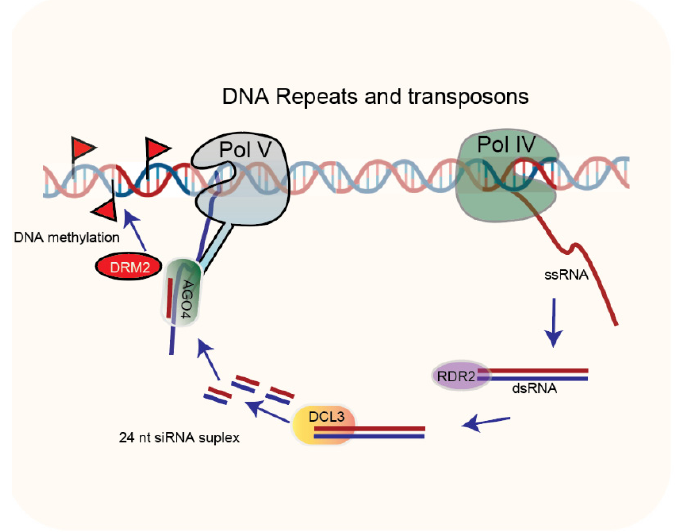
Figure 3. Pol IV initially transcribes DNA repeats and transposons. RNA-dependent RNA polymerase 2 (RDR2) then produces dsRNAs, DCL3 to process dsRNAs to 24-nucleotide siRNAs, which are stabilized by methylation on their 3 ′ -terminal 2 ′ -O-methyl group that is introduced by HEN1 and then loaded onto AGO. The AGO4 recruits DOMAINS REARRANGED METHYLTRANSFERASE 2 (DRM2) during Pol V mediated transcription, responsible for de novo methylation at the homologous genomic sites, resulting in transcriptional gene silencing (TGS).